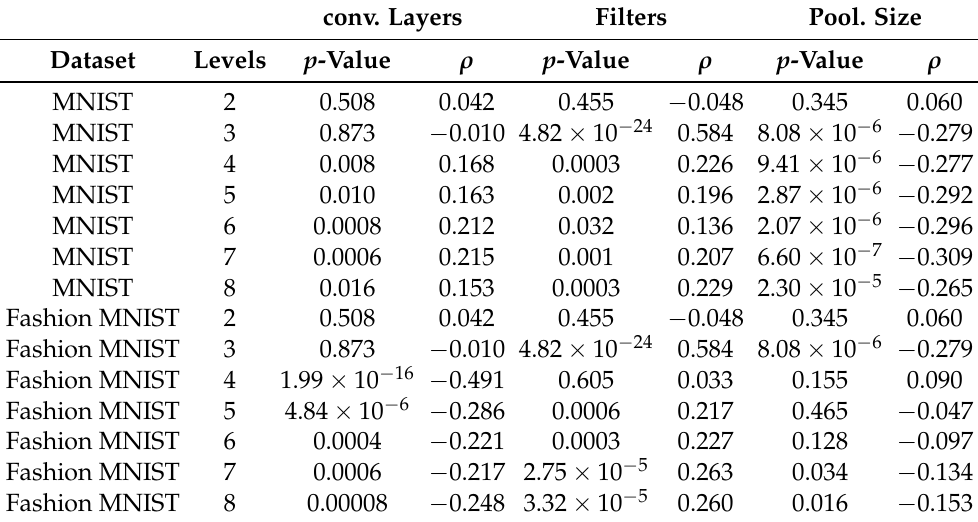
Table 10. Spearman’s correlation test between the number of convolutional layers/number of filters/size of pooling layers and the categorical accuracy for each experiment using quantization levels between 2 and 8.